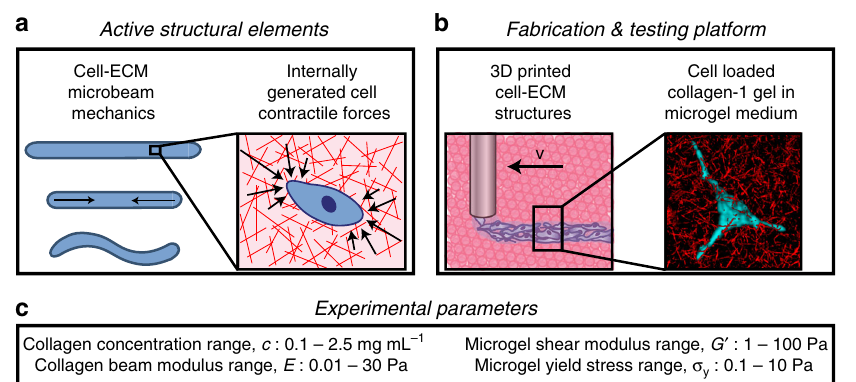
Fig. 1 Packed microgels provide a mechanically tuneable environment for methodical studies of collective cell mechanics in 3D. a Analogous to externally applied loads in classical beam mechanics, internal forces generated by contracting cells drive the undulation of microbeams made from ECM. b Fabricating cell – ECM microbeams is performed by 3D printing into a cell culture medium made from jammed microgels. This soft environment provides mechanical support to extremely delicate beams while simultaneously facilitating macroscale deformations driven by cell contraction. c We systematically investigate cell-driven mechanical behaviors by varying the properties of ECM microbeams and the surrounding microgel medium over the ranges given